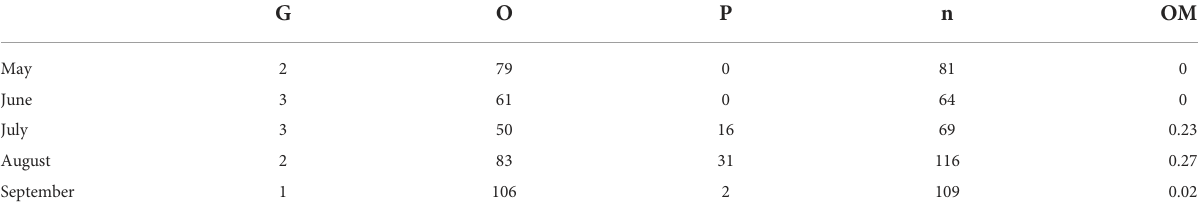
TABLE 2 The number of krill in each sexual development stage (SDS) from May to September.